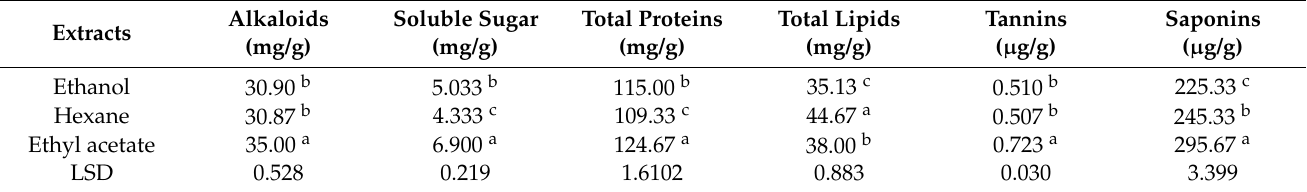
Table 1. Phytochemical quantitative analysis of Echinops spinosissimus